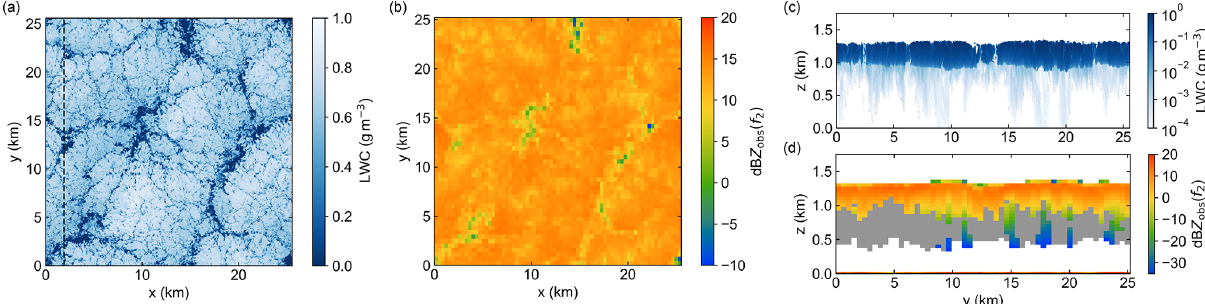
Figure 8. Selected results from VOCALS forward simulations. (a) Model LWC field for z = 1250m. (b) Corresponding observed reflectivity map at 174.8GHz for the range bin centered at 1250m height. (c) Vertical LWC profiles for the along-track path indicated by the dashed line in panel (a) , with drizzle clearly visible below cloud base, and (d) corresponding 174.8GHz observed reflectivity profiles. The gray shaded region in panel (d) indicates where the multiple-scattering mask has been applied, using the same criteria as in the GATE case.